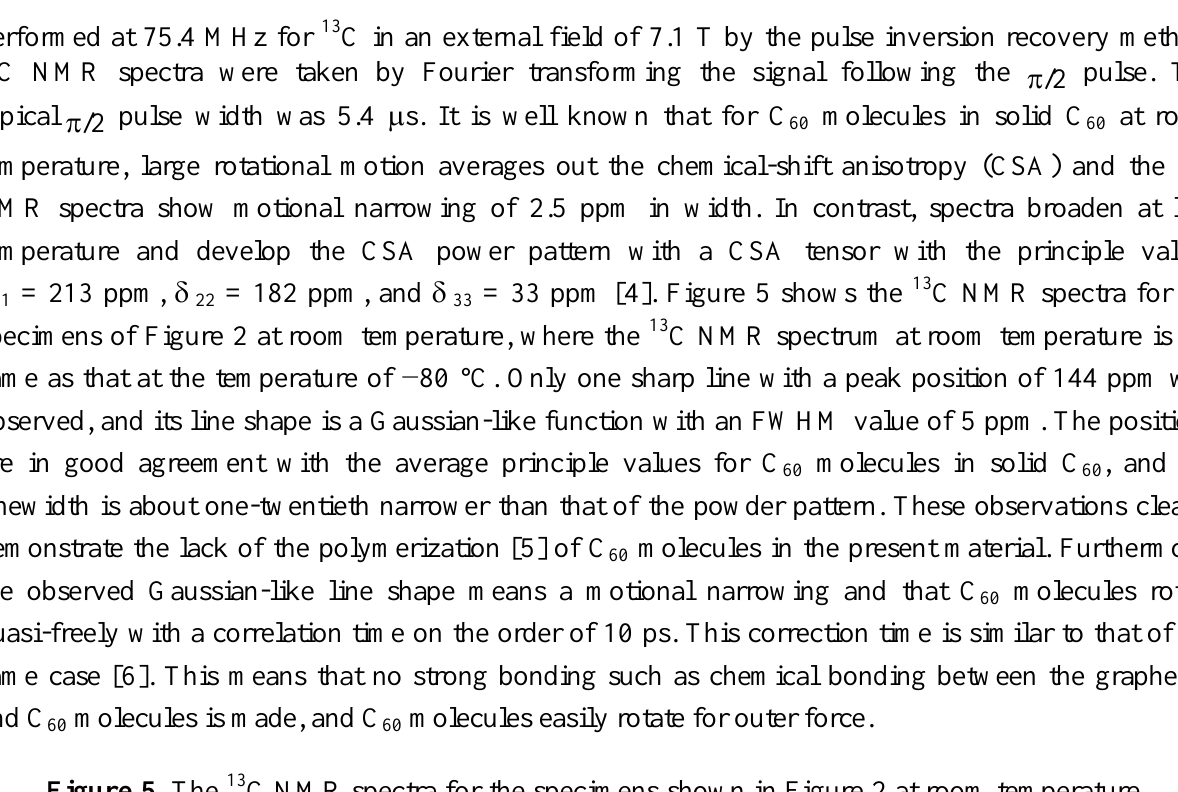
Figure 5. The 13 C NMR spectra for the specimens shown in Figure 2 at room temperature. Only one sharp line with a peak position of 144 ppm [4] was